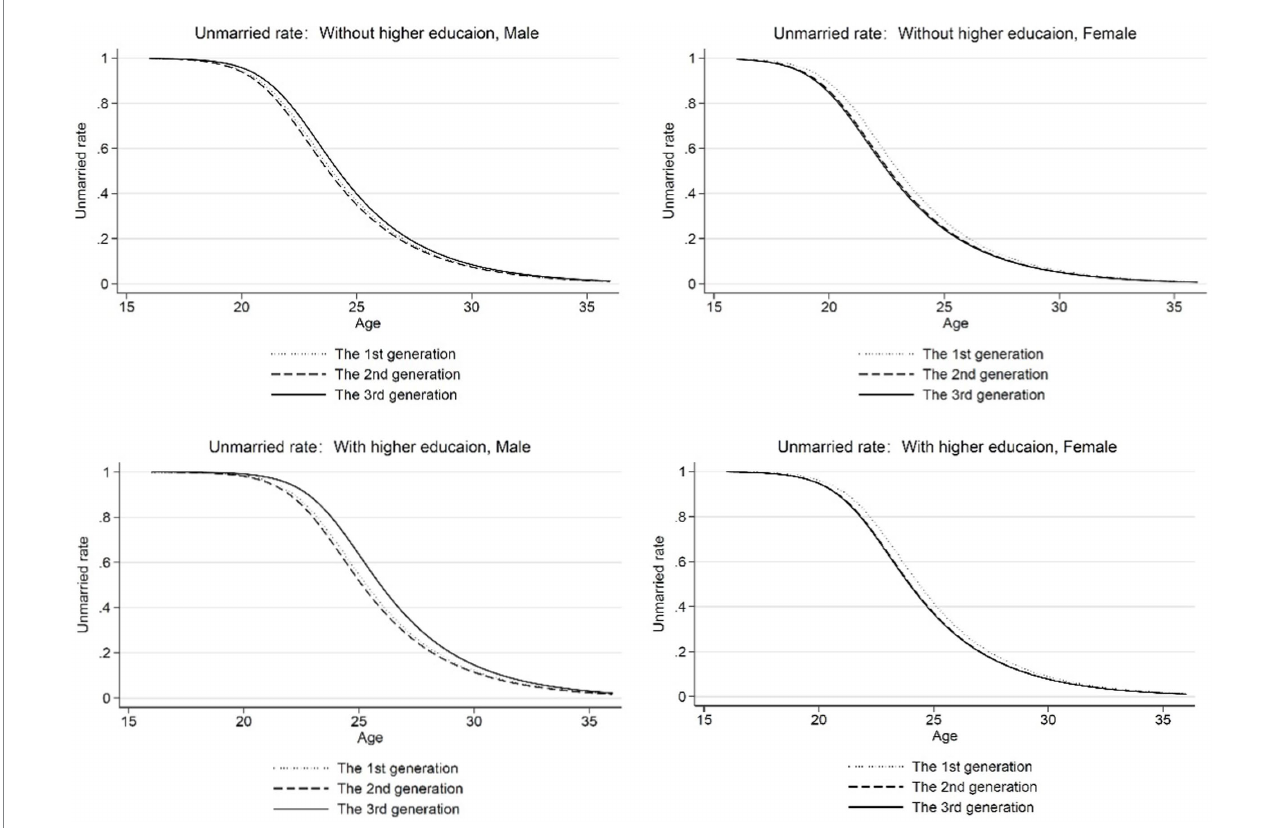
FIGURE 4 Age—unmarried rate (controlling for micro and macro variables). Micro variables include the parent’s level of education, the number of siblings, and the maximum age difference between the parents and their children. Macro variables include the moving average growth rate of real GDP of the respondents aged 20 and 29, the unemployment rate, degree of economic openness, and marriage rate of the population aged 20–25 when the respondents are aged